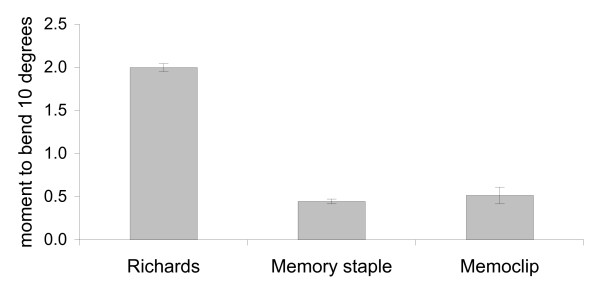
Bending stiffness for different staples.